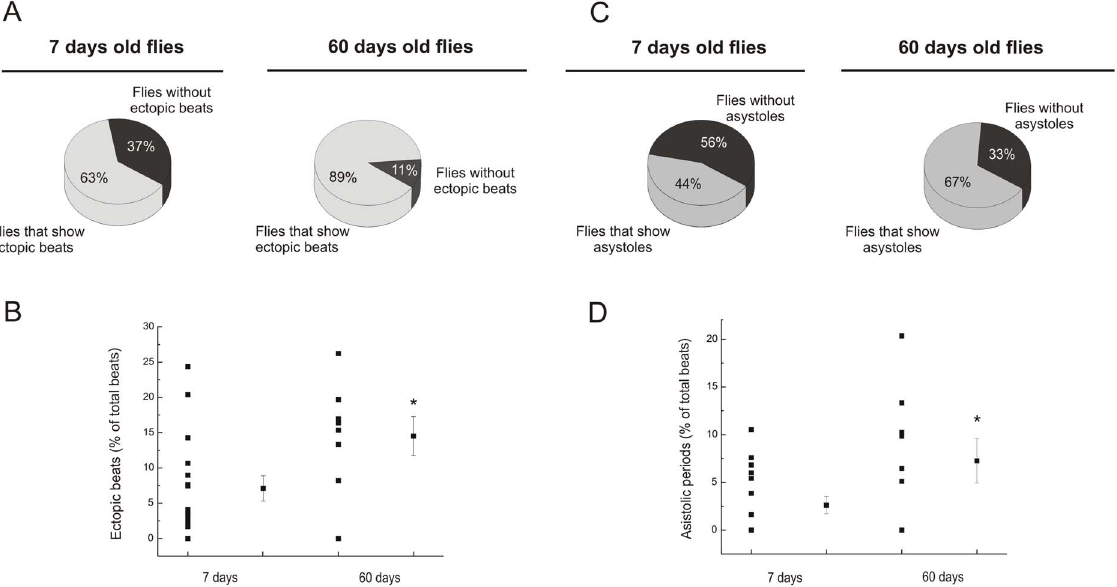
Figure 3. The incidence of ectopic beats and asystoles increases with aging. A. The number of individuals that exhibited ectopic beats was greater in old flies, compared with younger ones. B. The percentage of ectopic beats over total beats was increased in old flies. C. The number of individuals that exhibited asystoles was greater in old flies, compared with younger ones. D. The percentage of asystoles as function of total beats was increased in old flies. Mean 6 SEM of 57 flies. *p # 0.05.